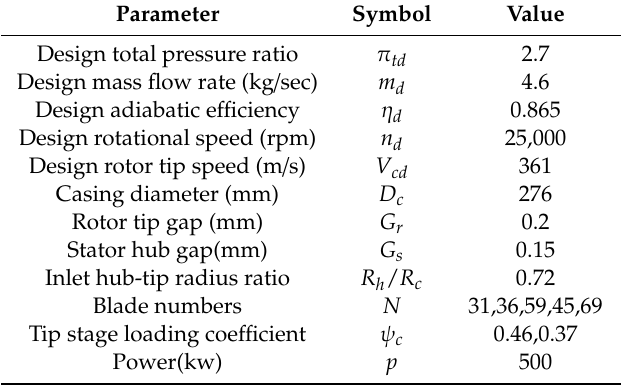
Table 1. Key aerodynamic and geometric parameters of the 2.5-stage highly loaded